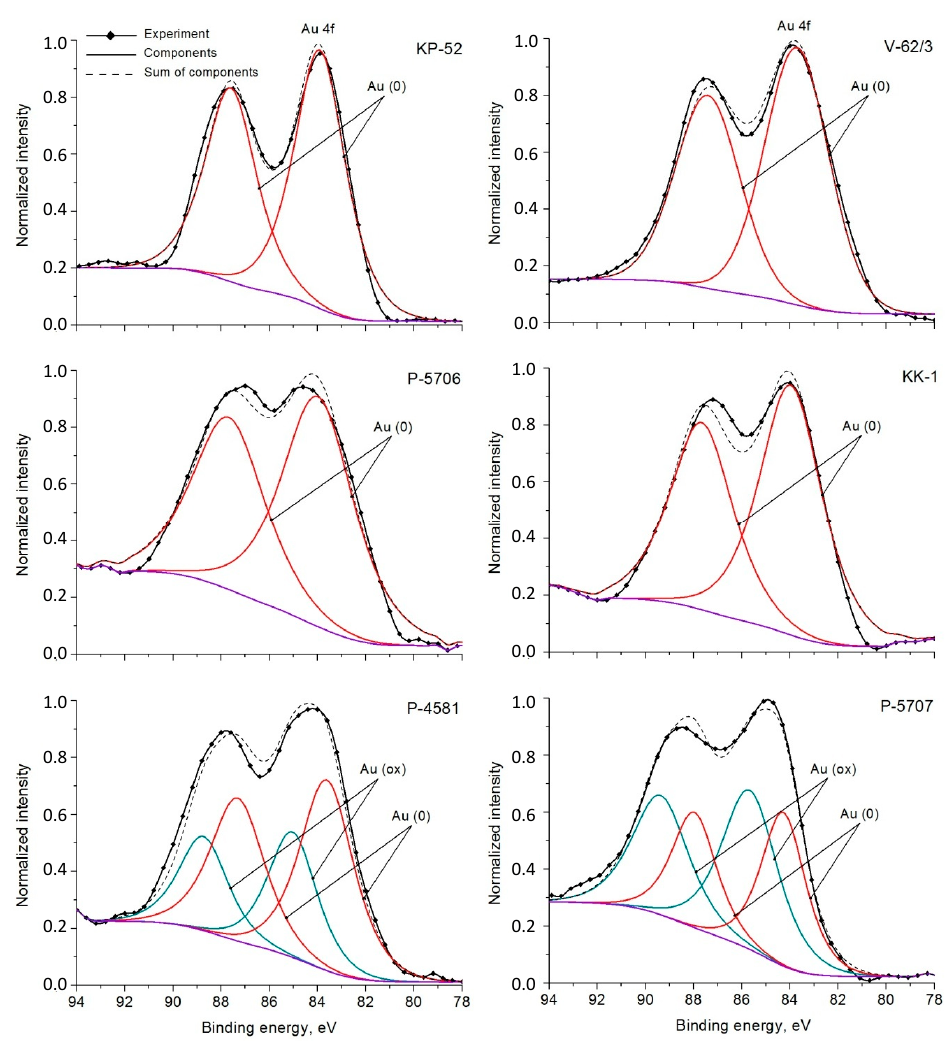
Figure 2. X-ray photoelectron spectra of Au 4f 7/2-5/2 native gold samples from the Amurskie Daiki (top line) and Kvartsevaya Sopka deposits (middle line, only metallic Au, bottom line, oxidized Au present).